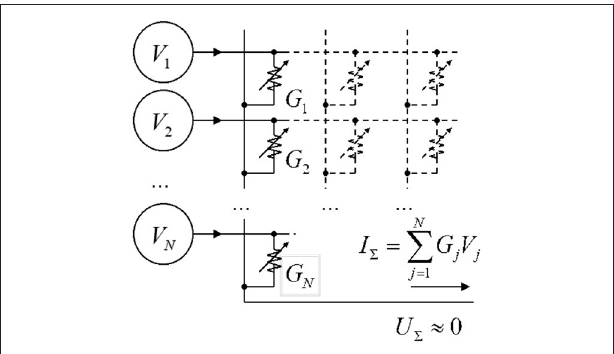
FIGURE 10 | Analog vector-by-matrix multiplication (VMM) in a crossbar circuit with adjustable crosspoint devices. For clarity, the output signal is shown for just one column of the array, while sense amplifier circuitry is not shown. Note that other VMM designs, e.g., utilizing duration of applied voltage pulses, rather than their amplitudes, for encoding inputs/outputs, are now being actively explored see, e.g., their brief review in Bavandpour et al.